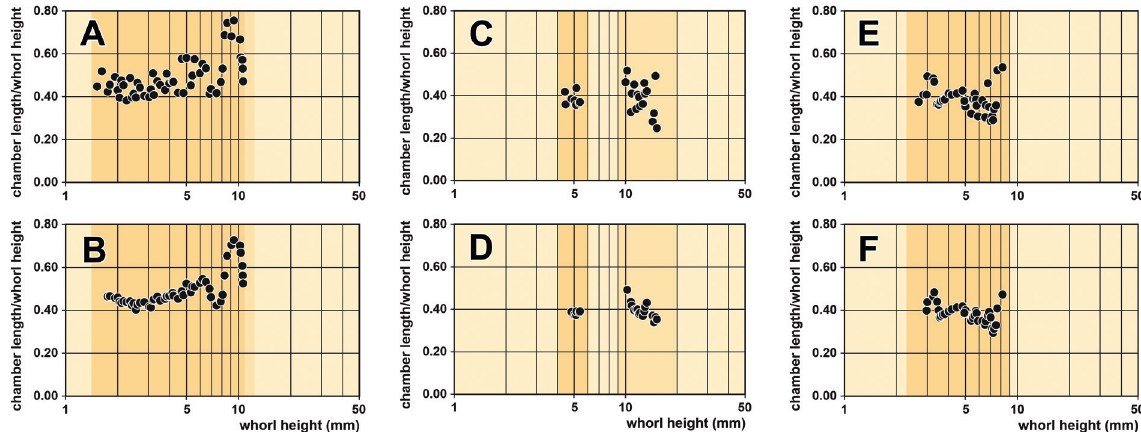
Fig. 41. Septum distances in Lituites perfectus Wahlenberg, 1818 from the Upper Grey Orthoceratite Limestone. Upper row = empirical data points; lower row = three data points averaged. A–B . Specimen MB.C.30542 (Neben Coll.) from Niederfinow (Brandenburg). C–D . Specimen MB.C.30543 (Krueger Coll.) from Oderberg (Bralitz) (Brandenburg). E–F . Specimen MB.C.11646 (Kgl. Forstakademie Eberswalde Coll.) from Eberswalde (Brandenburg).